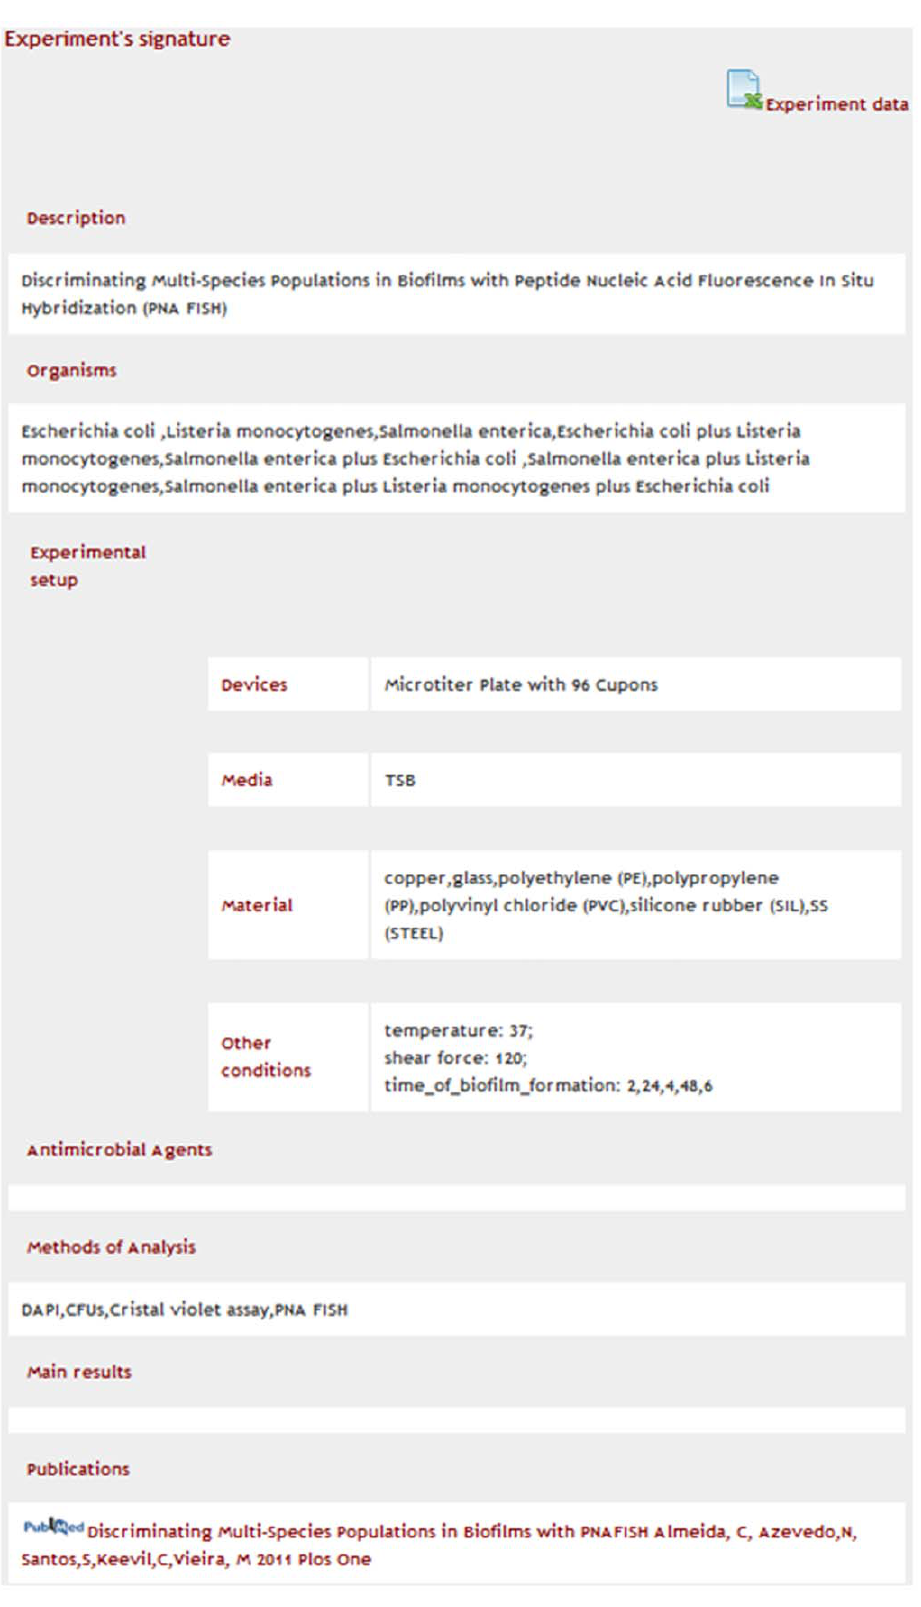
Figure 5. Extract of the study signature of the experiment ‘‘Discriminating multi-species populations in biofilms with peptide nucleic acid fluorescence insitu hybridization (PNA FISH)’’ (PMID: 21479268).